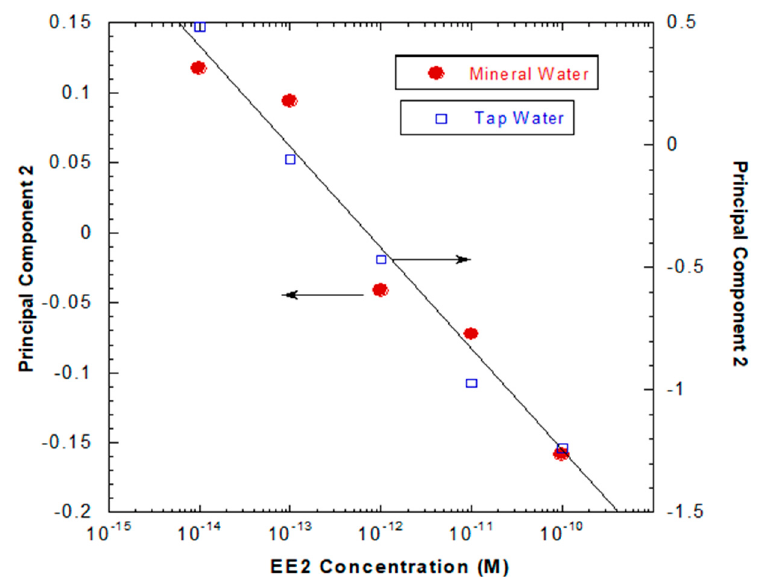
Figure 8. Plot illustrating the constant proportionality achieved when the sensor’s responses attained in both mineral and tap waters are plotted as a function of EE2 concentration.